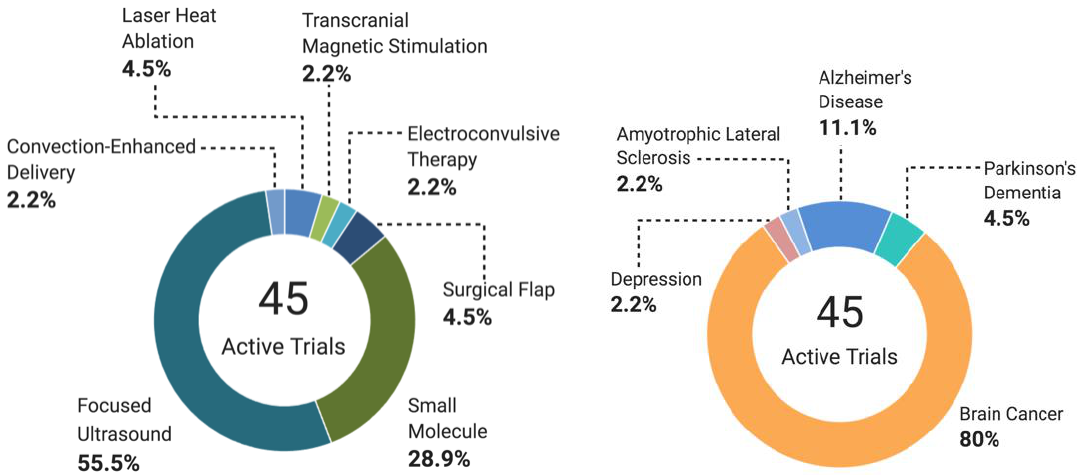
Figure 7. Summary of active BBBD clinical trials categorised by modulation method ( left ) and associated disease investigated ( right ). Currently 45 active clinical trials involving Blood–brain barrier Disruption are taking place. The majority of these trials are using focused ultrasound technology to facilitate greater efficacy of anticancer drugs to treat various gliomas.